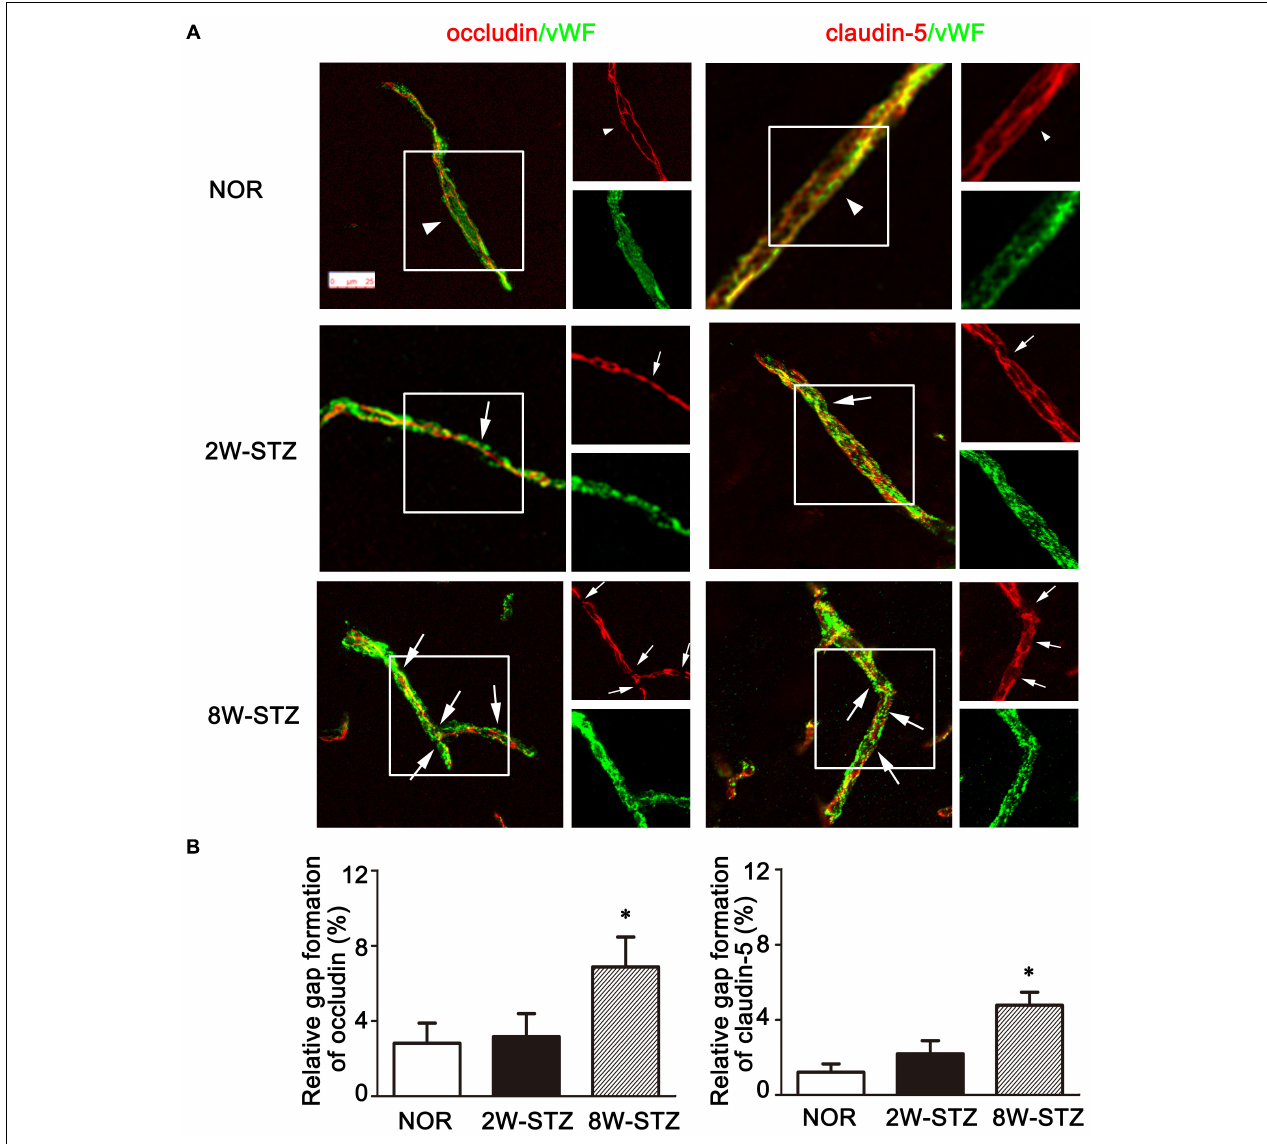
FIGURE 6 | Tight junction of Occludin and claudin-5 in the diabetic and normal rats. (A) Representative image of tight junction protein occludin and claudin-5 (red) showed continuous and linear expression along the vessel labeled with endothelial marker vWF (green) in the normal rats (arrowheads). Compared to the normal rats, the occludin and claudin-5 protein showed a discontinuous distribution in 8-week STZ rats (arrows). The box section of each large image was shown in the small figure on the right side. Scale bar = 25 µ m. (B) Bar graph showed the ration of the gap length to the vessel length among different groups. Data are mean ± SD, n = 6–8 per group. ∗ p < 0.05, 8W-STZ vs. normal rats. NOR, normal rats; 2W-STZ, 2-week STZ; 8W-STZ, 8-week